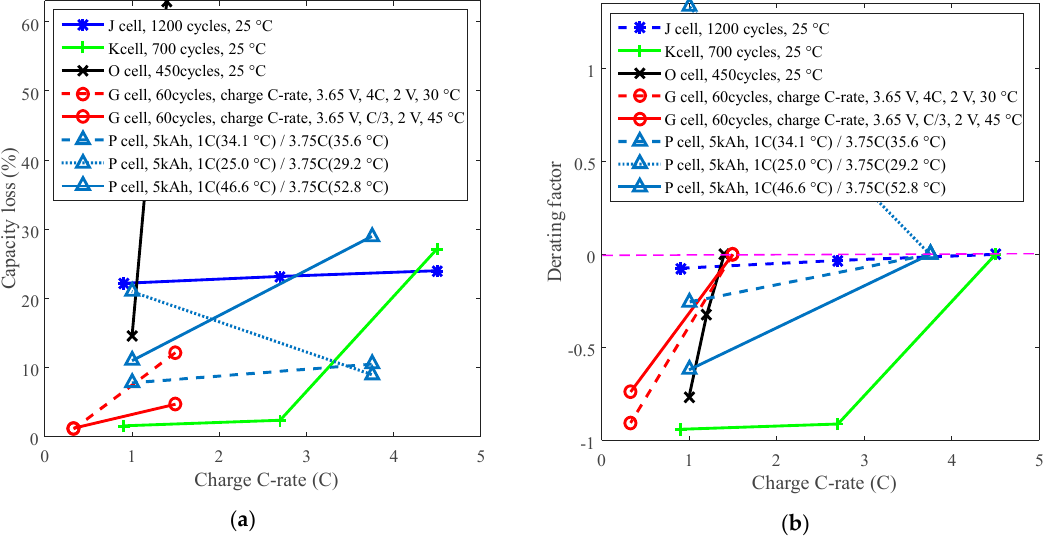
Figure 10. Derating of charge C-rate. (a) Capacity loss. (b) Derating